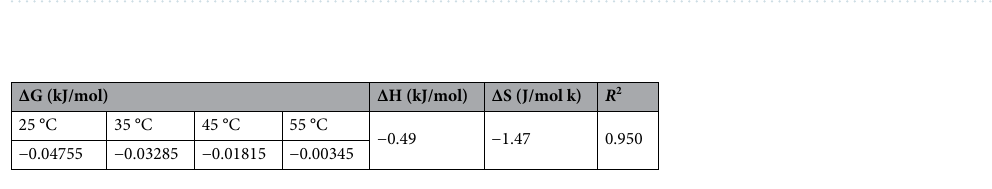
Table 3. Thermodynamic parameters for DC adsorption.